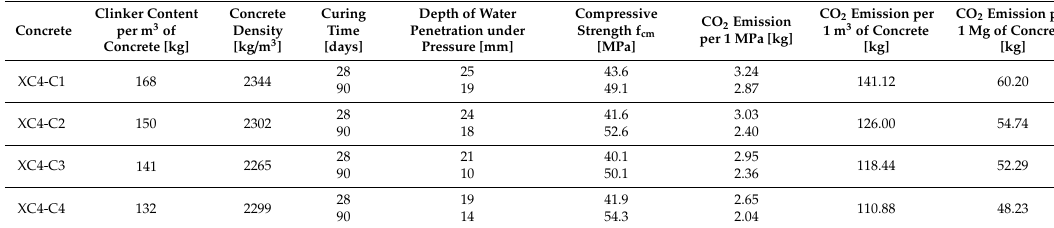
Table 7. Properties of XC4 concretes with CO 2 emission level.